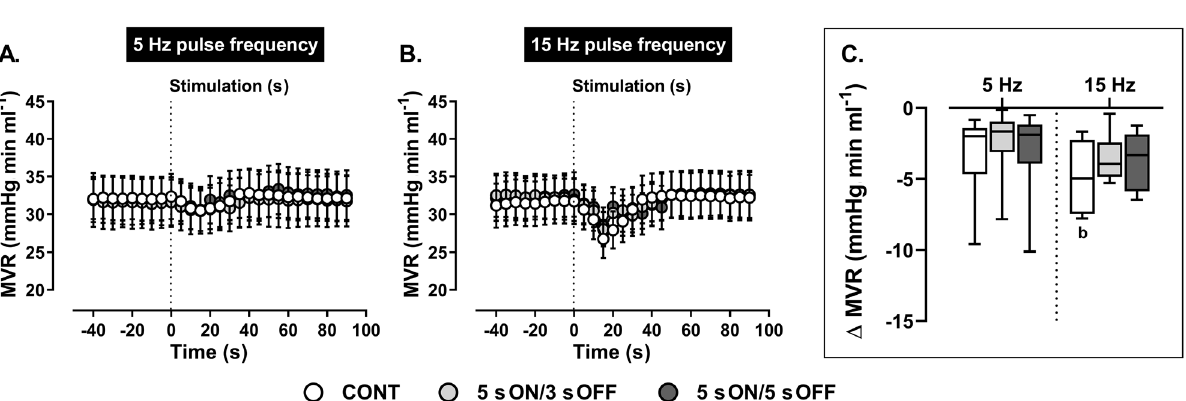
Figure 5. Effect of ( A ) low (5 Hz) and ( B ) high (15 Hz) frequency continuous (CONT) versus intermittent (5 s ON/3 s OFF and 5 s ON/5 s OFF) aortic depressor nerve (ADN) stimulation (0.4 mA, 0.2 ms for 20 s) on reflex reductions in mesenteric blood flow (MBF) in pentobarbital-anesthetized spontaneously hypertensive rats (SHRs). ( A,B ) The time trend for reflex MBF responses to ADN stimulation, while ( C ) shows absolute changes (ml min −1 ) in MBF in response to ADN stimulation. Results are expressed as mean ± SEM ( n = 9), analyzed by a two-way ANOVA followed by followed by Bonferroni’s post hoc test. a: P < 0.05 versus continuous stimulation for each frequency and b: P < 0.05 versus respective stimulation across frequencies.